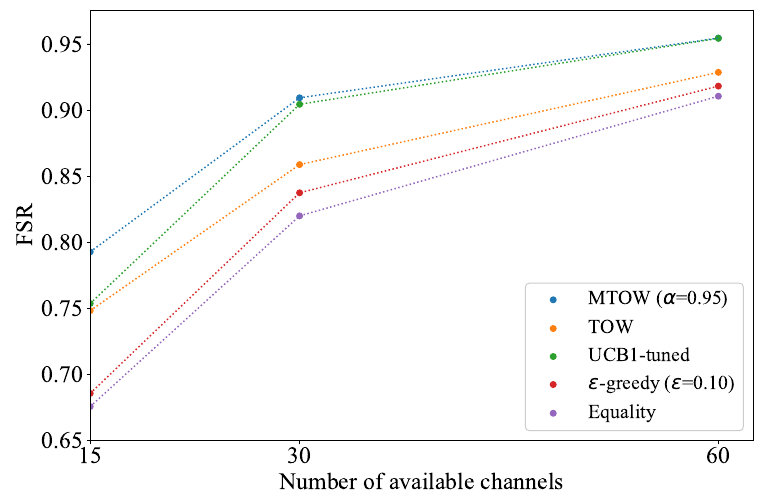
Figure 9. Number of available channels vs. FSR in the IoT network where 10,000 nodes and 12 channels may be